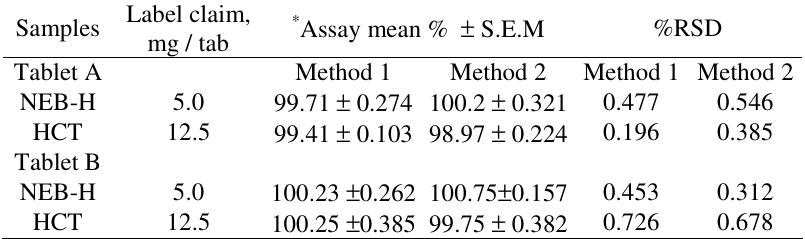
Table 1. Analysis of formulation by